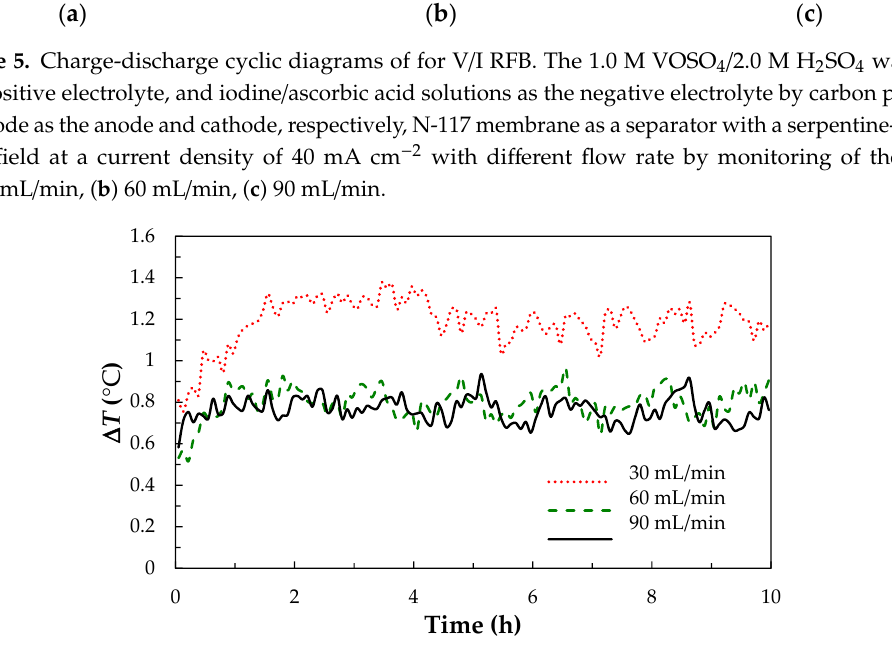
Figure 6. The temperature change ( ∆ T ) vs. the charge-discharge cycle time for V / I RFB by Figure 5 charge / discharge conditions with di ff erent flow rate by monitoring of the ITI in: 30 mL / min, 60 mL / min and 90 mL / min without modified key